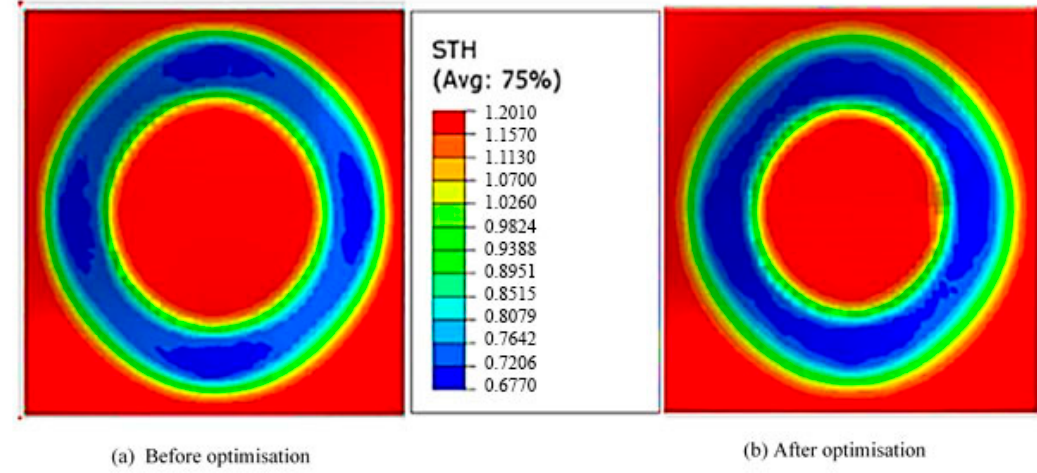
Figure 11. Thickness distribution of the ( a ) single-stage and ( b ) the optimised multistage SPIF process.